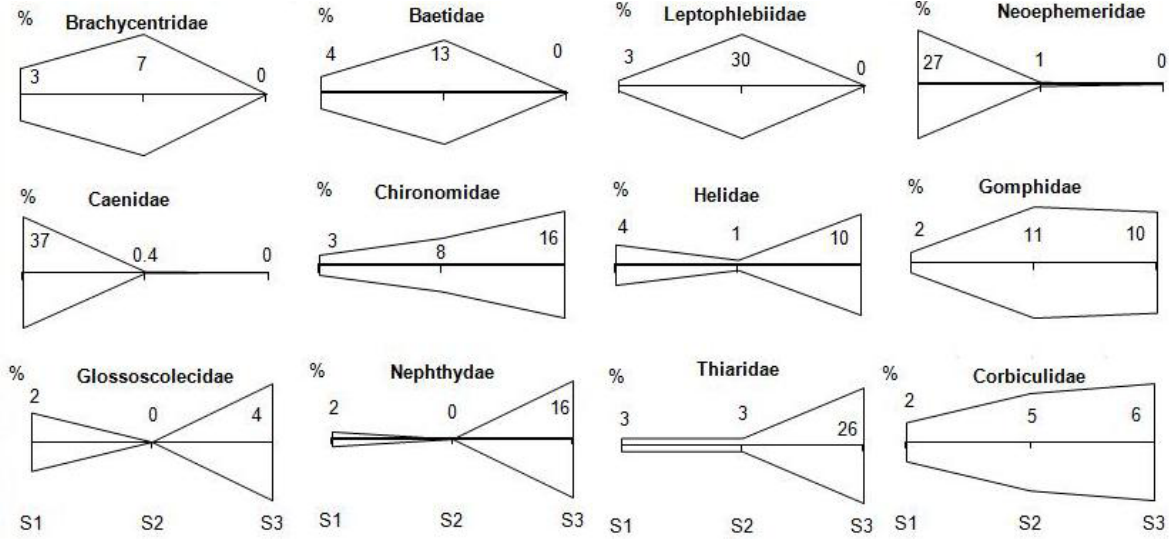
Figure 3. Few taxon indicates gradual increase or decrease along the length of the river with respect to land use.